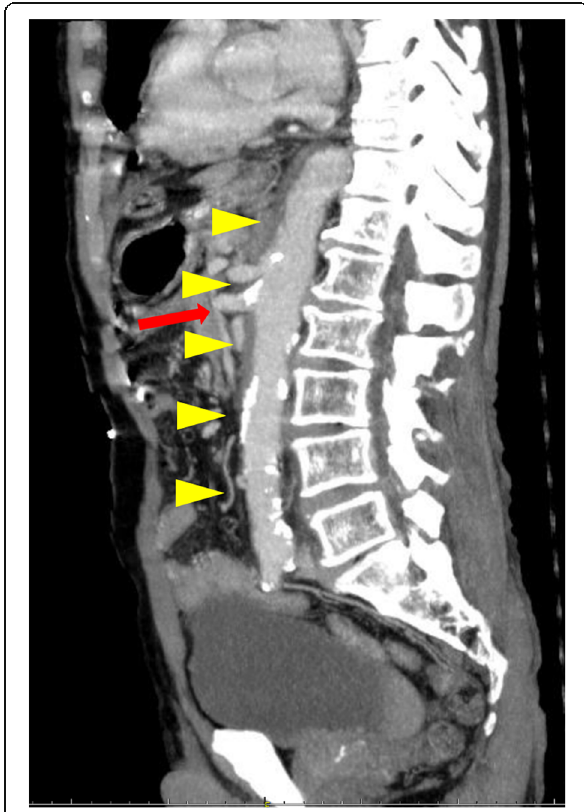
Fig. 1 Contrast-enhanced CT indicated a type B AD (yellow arrowheads) including the SMA (red arrow)